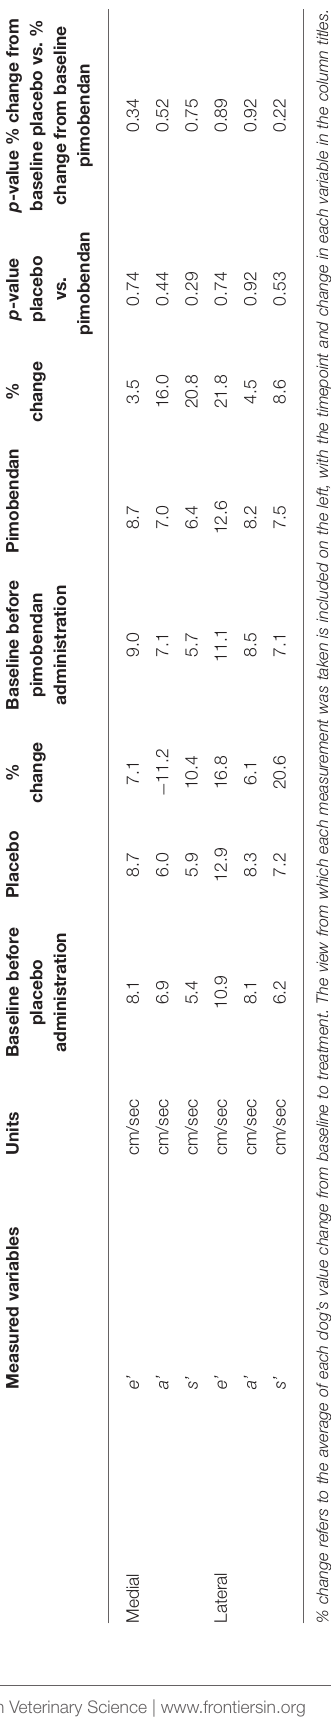
area change was calculated from left ventricular area tracings excluding the papillary muscles in systole and diastole. Strain was calculated by lining up the QLab aCMQ (automated cardiac motion quantification, Philips Ultrasound) tracing with the 2D cine of the ventricle, the computer system tracked the movement through a cardiac cycle. Long axis right parasternal views were used for ejection fraction (EF) measurements via the Simpson’s method of discs. Pulsed wave Doppler and TDI waves were recorded from left apical four and five-chamber views. Velocity time integrals (VTIs) were measured by tracing flow profiles and used in LV outflow volume calculations. Systolic time intervals were assessed from the left ventricular outflow tract (LVOT) trace paired with the simultaneous ECG. Doppler waves were measured according to standard practices (21) LA maximum and minimum volumes, jet areas, and continuous wave measurement of MR were taken from left apical four and two chamber (orthogonal) views. LA volumes were estimated based on these two views (“biplane method”) (22) using Simpson’s method of discs. LA maximum (LA Vmax) and minimum sizes (LA Vmin) were used to calculate total LA emptying fraction (LA EF) and left atrial functional index (LAFI). Left atrial functional index is a value used clinically in humans (23) and is calculated with the following